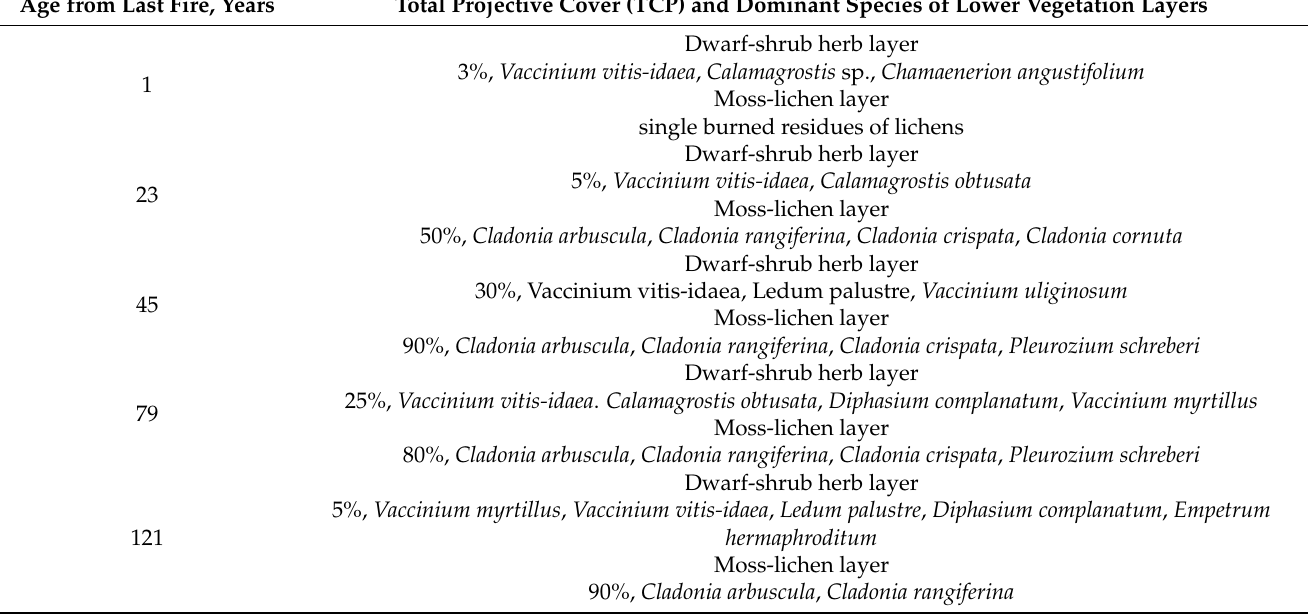
Table 1. Total projective cover (TCP) and dominant species of lower layers of plant communities of Pinetumvaccinioso-cladinosum formed on Albic